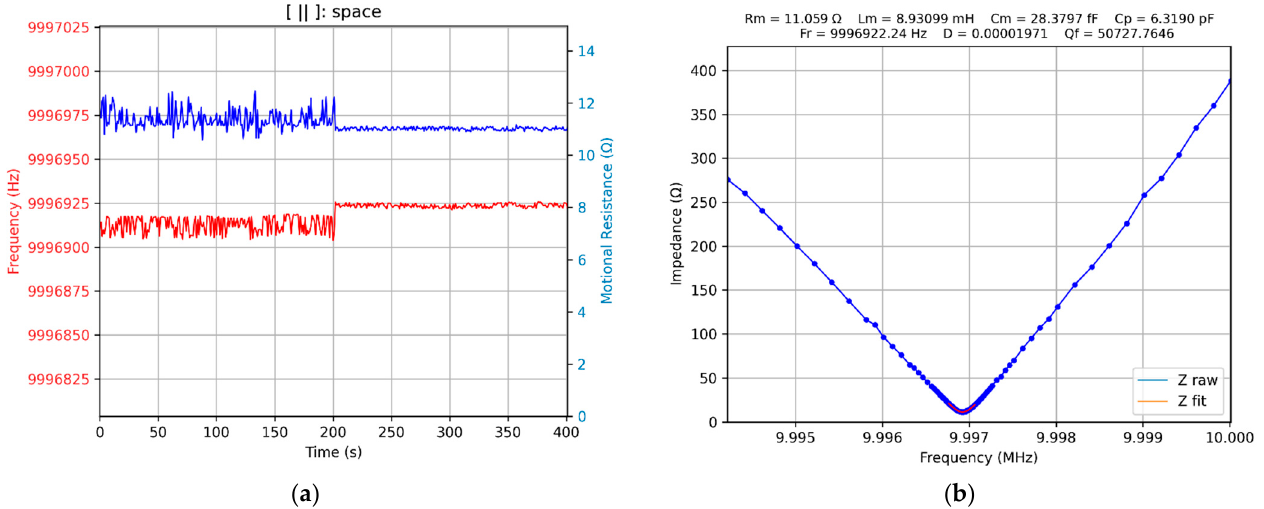
Figure 11. The virtual QCM: ( a ) series resonance ( 𝐹 (cid:3045) ) and motional resistance ( 𝑅 (cid:3040) ) with constant steps (50 Hz, 0–200 s) and bioinspired steps (200–400 s), ( b ) bioinspired series resonance frequency tracking in VIA.